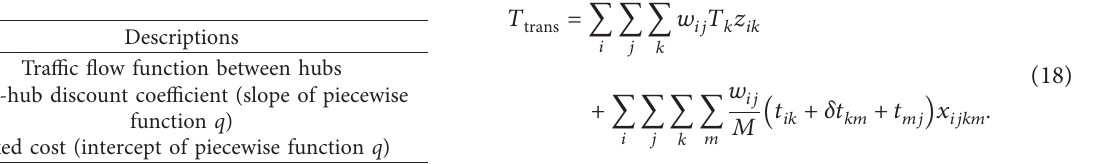
Figure 4: Piecewise linear cost functions. This figure shows that the piecewise linear functions can solve the nonlinear problem by using secant line method to simulate the original nonlinear function. Table 3: The variables used for illustrating the piecewise linear cost